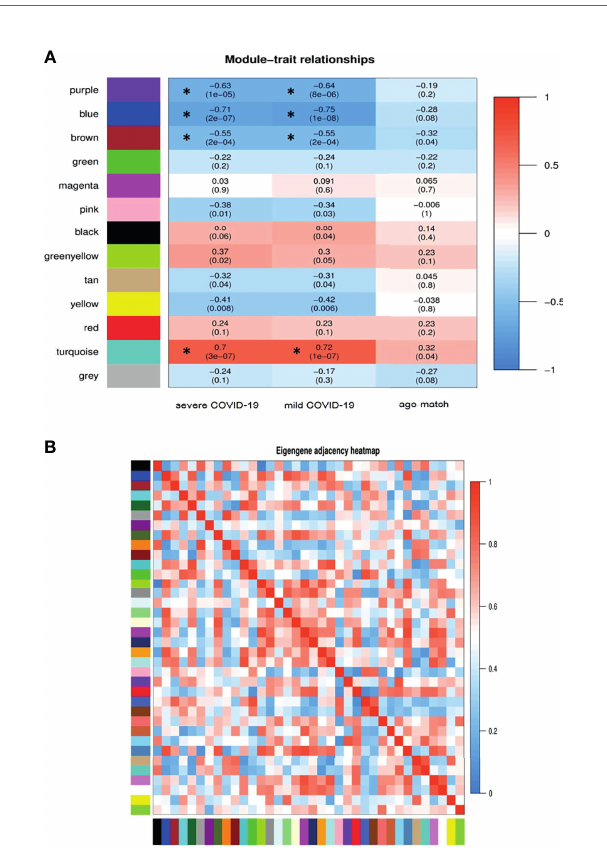
FIGURE 6 | Module-trait relationships analysis. (A) Module-trait relationships (MTRs) between detected modules and disease severity of COVID-19. Module-trait relationships MTRs are obtained by calculating the correlation between the traits and the module eigengenes. The red and blue colors indicate strong positive correlation and strong negative correlation, respectively. Rows represent module eigengene (ME) and columns indicate disease severity of COVID-19. Asterisks corresponds signi fi cant highly- correlated values. (B) Eigengene adjacency heatmap indicate relationship among all the modules.